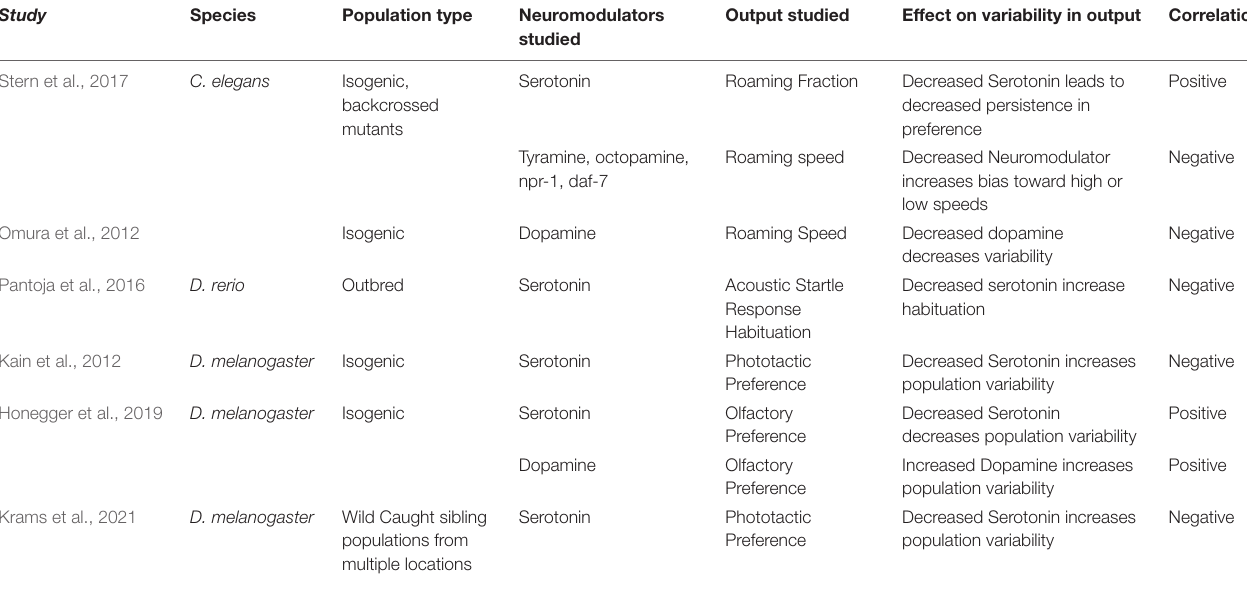
TABLE 1 | Examples of ties between neuromodulators and individuality.